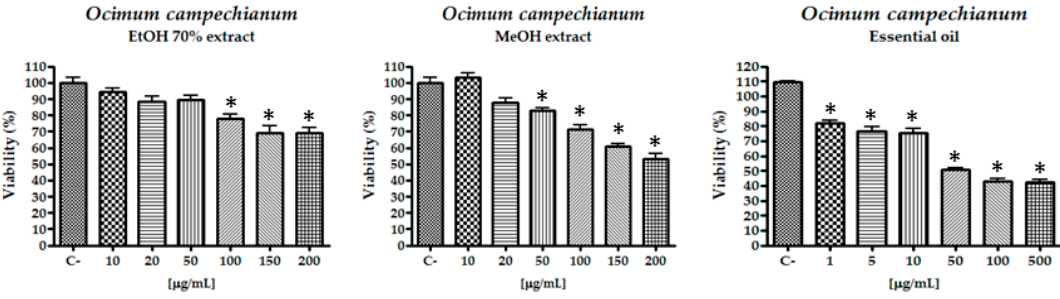
Figure 1. Cell viability of O. campechianum extracts and EO against A549 cell line. * p < 0.01